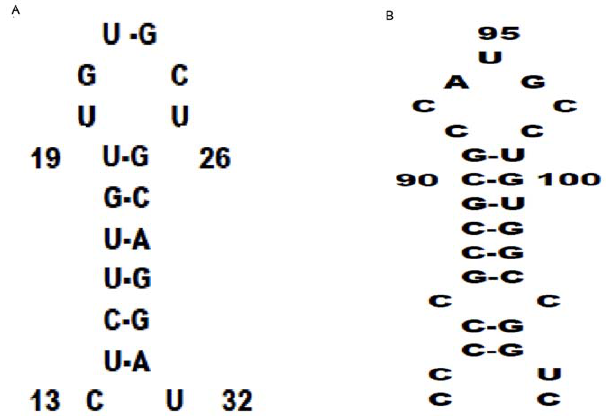
Figure 4. Secondary structure of TS:N20. A , Secondary structure for the zebrafish TS RNA sequence corresponding to nt 13–32, TS:N20, which was predicted with the RNA MFold program, generating a stem- loop secondary structure. B , The secondary structure of the cis -acting element localized in the upstream region of human TS mRNA [8], which binds specifically with human